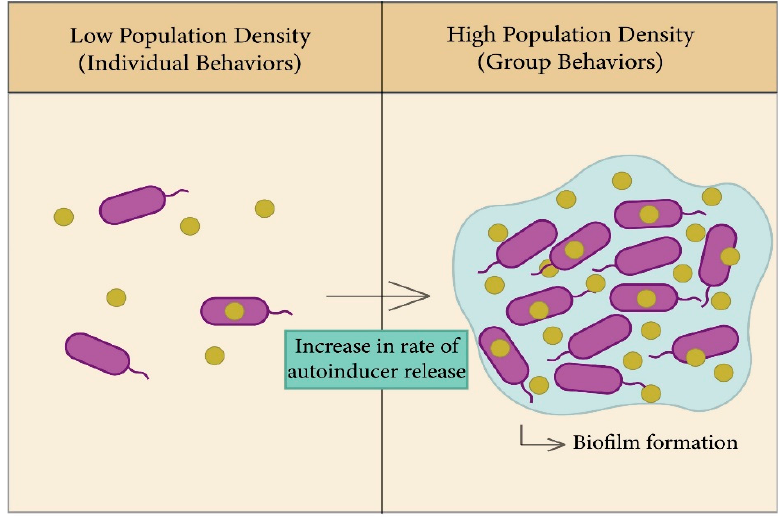
Figure 3. General principle of the QS system. Left figure : Each species begins to secrete autoinducers into the external environment, and the population density increases. Right figure : Increased rate of autoinducer release to form biofilm due to gene expression. Table 1. Autoinducers molecules from different bacteria.